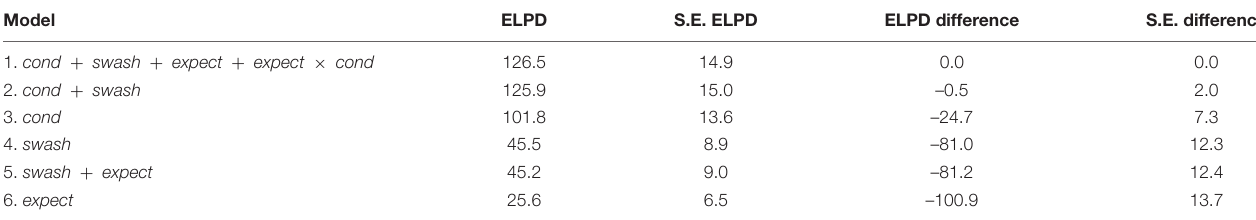
TABLE 7 | Comparison of ELPD across several models.